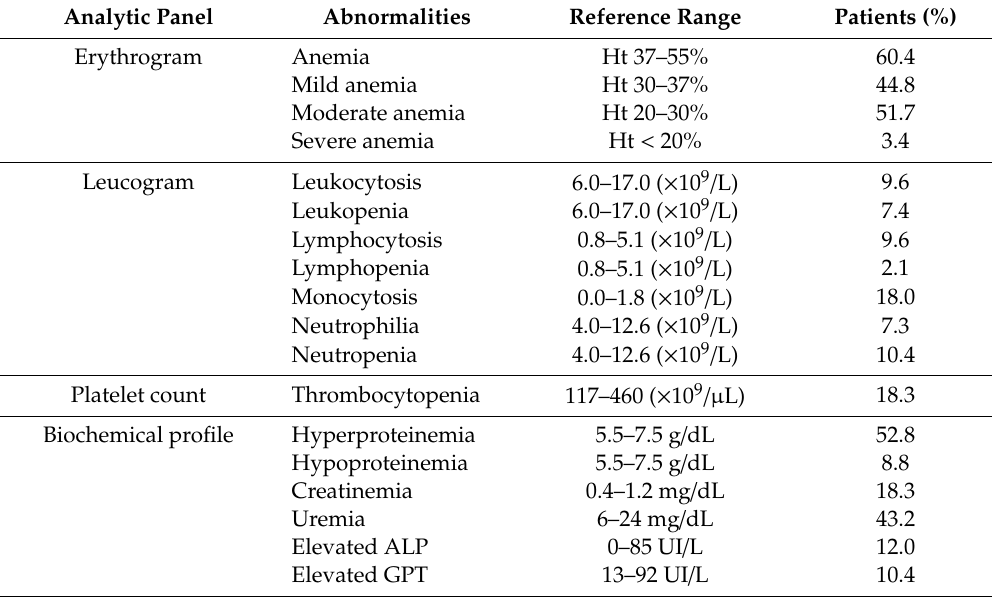
Table 3. Clinicopathological abnormalities compatible with CanL at the time of diagnosis, n =